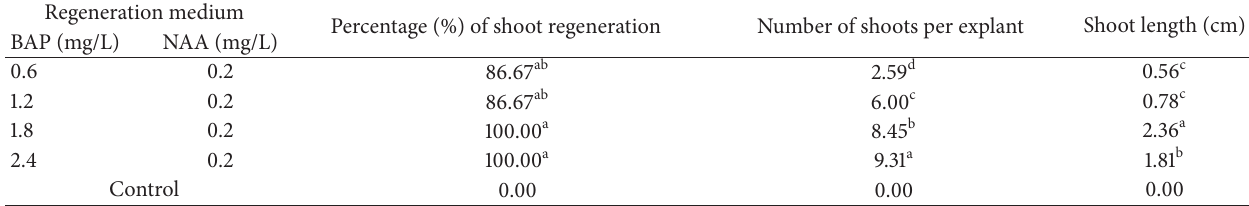
Table 1: Effects of various concentrations of BAP-NAA on shoot regeneration from stem node explant of O. acutiden . Regeneration medium